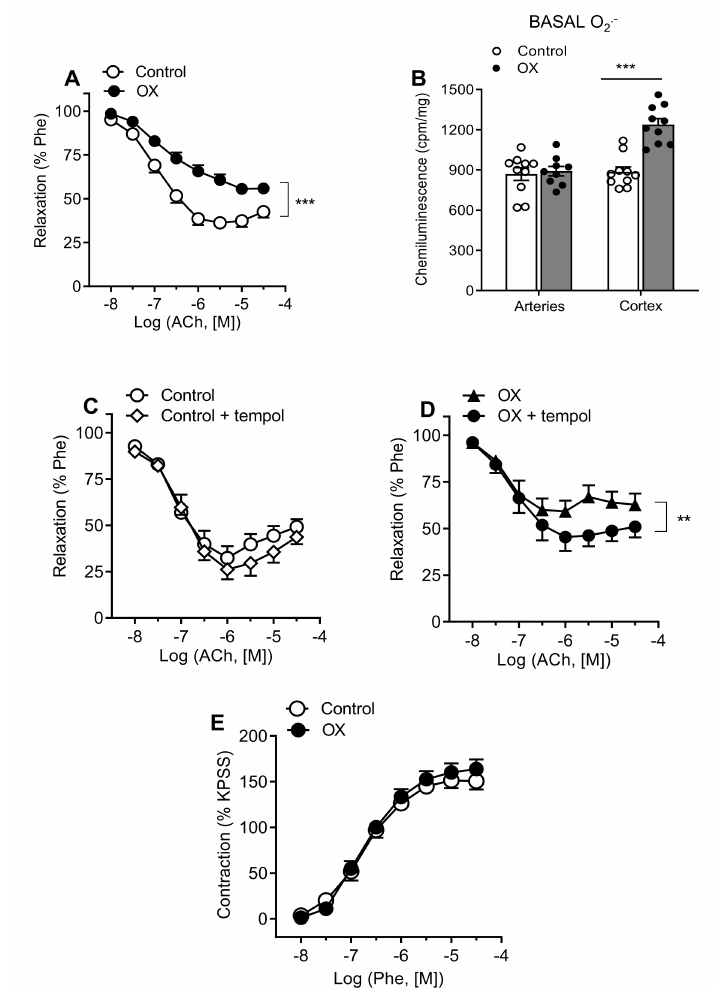
Figure 1. Impaired endothelium-dependent relaxations of the renal preglomerular arteries are associated with higher basal O 2 − generation in the renal cortex in hyperoxaluric rats (OX) and ameliorated by the SOD mimetic tempol. ( A ) Comparative endothelium-dependent relaxations of intrarenal arteries levels in control and OX rats. Results are given as a percentage of the phenylephrine (Phe)-induced contraction. Data are means ± SEM of 4 animals (1–2 arteries from each rat). Statistical differences were calculated with unpaired t -test *** p < 0.001. ( B ) Basal ROS generation in kidney cortex and renal interlobar arteries measured by lucigenin-enhanced chemiluminescence. Results are given as counts per minute (cpm) per mg of tissue. Bars represent mean ± SEM of 5 animals. Statistical differences were calculated with unpaired Student’s t -test *** p < 0.001 versus basal levels. ( C , D ) Effect of tempol on the relaxant responses elicited by ACh in rat renal interlobar arteries in control ( C ) and OX groups ( D ). Statistical differences were calculated by unpaired Student’s t -test ** p < 0.01. ( E ) Constrictor responses to Phe in renal interlobar arteries from control and hyperoxaluric rats (OX). Results are expressed as absolute values (Nm − 1 ). Data are shown as the mean ± SEM of 7–8 arteries (4